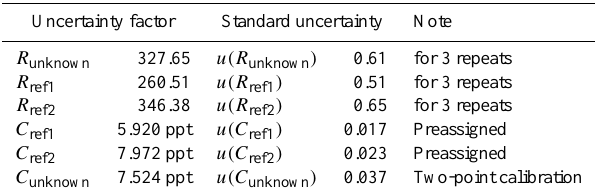
Table 4. Total uncertainty budget of the working standard (CC315007).